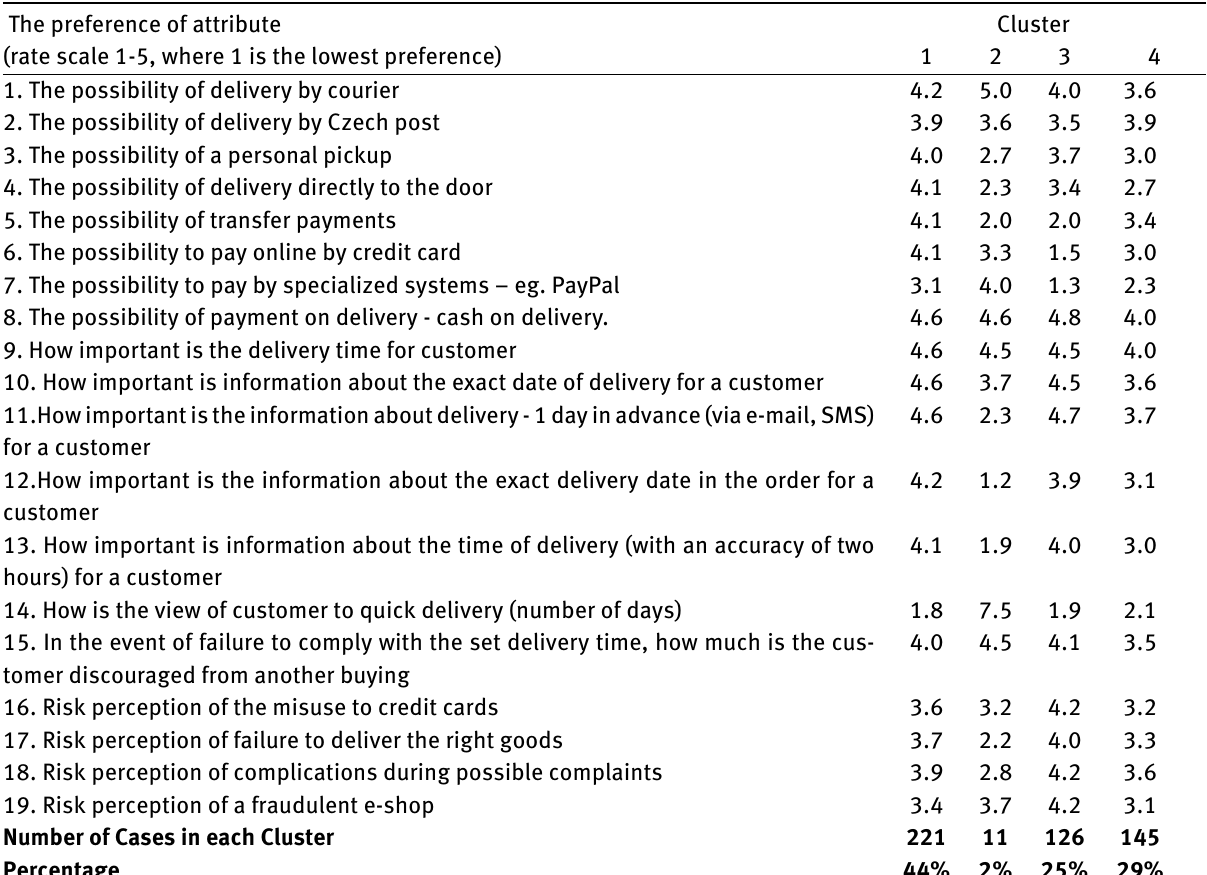
Table 2: Final Cluster Centers of selected